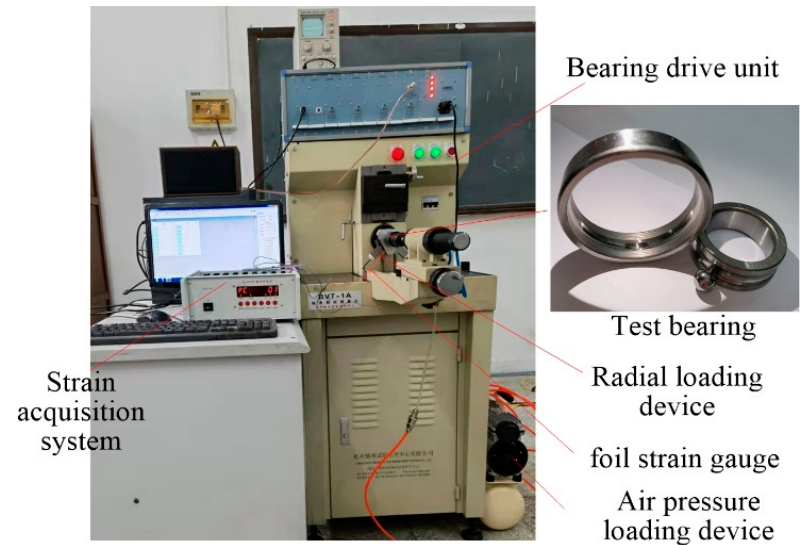
Figure 12. Strain test device for cageless ball bearing. Combining Equations (8)–(12) and the relationship between stress and strain, it was obtained that the stress in the transition region between the rolling element and the variable diameter raceway is 621.7 MPa, and the contact stress in the variable diameter raceway is 224.444 MPa. Combined with the structure of the test sample, the stress distribution at a depth of 2 mm along the load direction is σ z 1 = 3.0855 MPa, the stress in the variable diameter raceway is σ z 2 = 0.0497 MPa after conversion. The contact strain between the rolling element and the transition region of the variable diameter raceway of the cageless ball bearing is ε z 1 = 2.269 × 10 − 5 on the surface, the micro strain is 22.69 µε . In the variable diameter raceway, the surface strain value is ε z 2 = 3.6538 × 10 − 7 , the micro strain is 0.36538 µε . Through the calculation, it is observed that the strain in the variable diameter raceway is small relative to the strain in the transition region that it can be ignored. Thus, the strain gauges are only attached to the entry and exit of the variable diameter raceway, the strain data are collected to obtain the contact strain test results of the cageless ball bearing as shown in the Figures 13 and